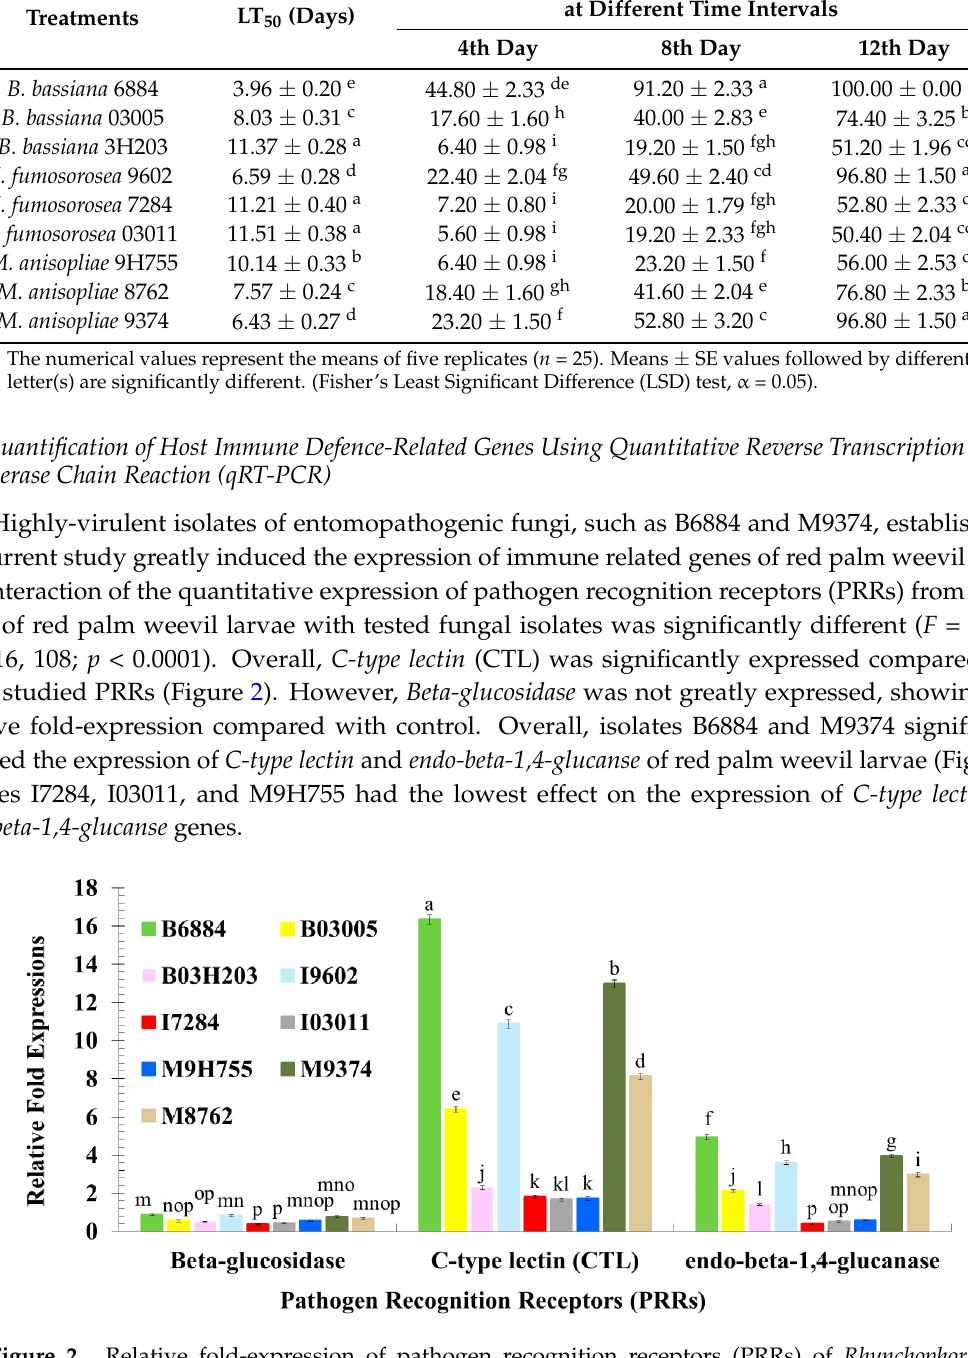
Figure 2. Relative fold-expression of pathogen recognition receptors (PRRs) of Rhynchophorus ferrugineus larvae in response to fungal infections using quantitative real-time PCR. Means ± SE values followed by different letter(s) are significantly different. (Fisher’s Least Significant Difference (LSD) test, α = 0.05).